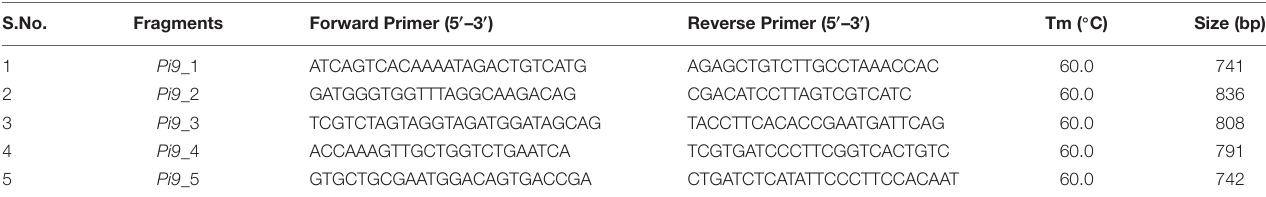
TABLE 2 | List of overlapping primers used for the amplificati1on of 2.9 kb nucleotide binding site-leucine-rich repeat (NBS-LRR) region of Pi9 gene using primer walking technique.